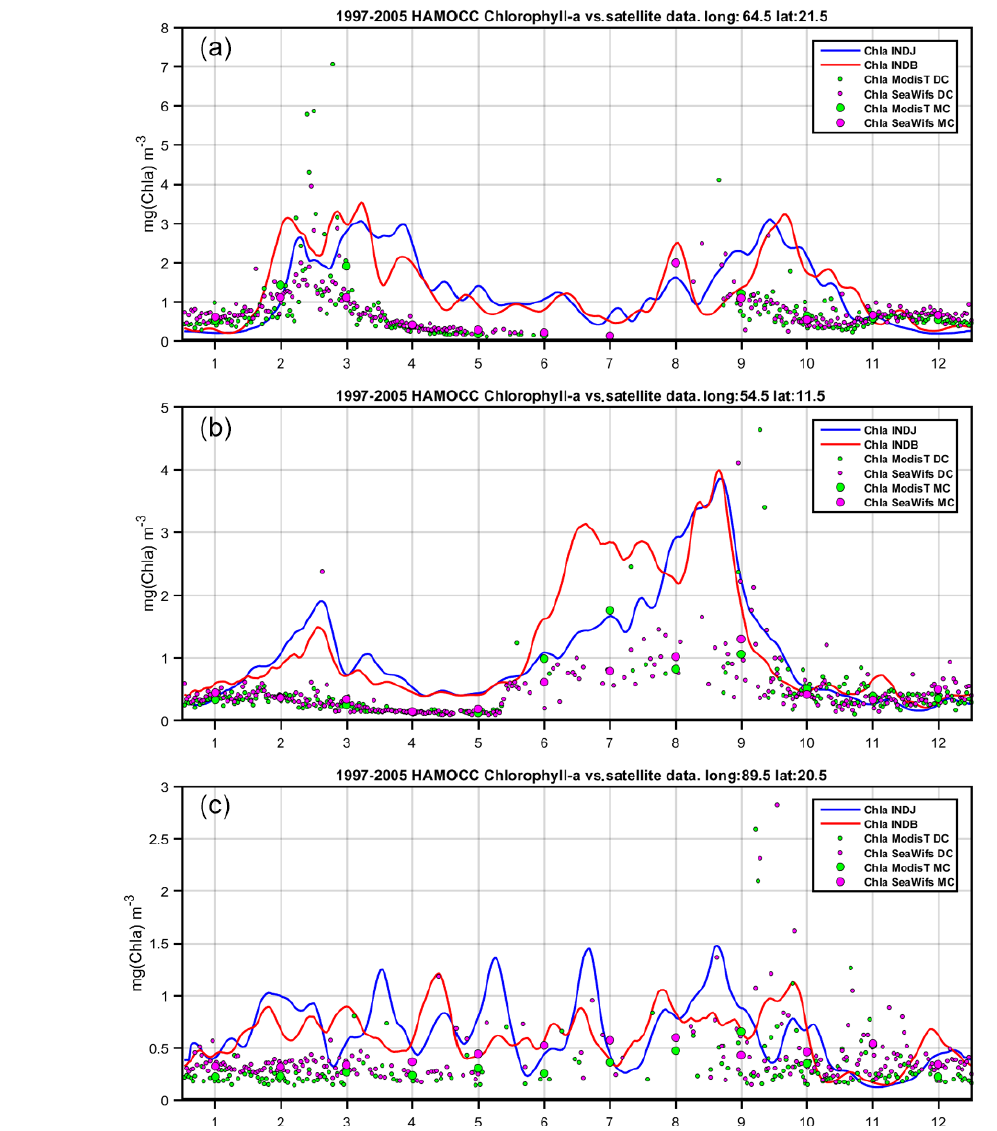
Figure 4. Comparison of the simulated (INDJ and INDB) and observed (SeaWiFS, MODIS Terra) surface chlorophyll a concentration in the Arabian Sea (a) , Somali upwelling area (b) and the Bay of Bengal (c) . DC and MC – daily-mean and monthly-mean climatic averaging of satellite data for the period 1997–2005, respectively. The blue and red curves (Chl a INDJ and Chl a INDB) are daily-mean climatic averaging of modeled surface chlorophyll a concentration for the period